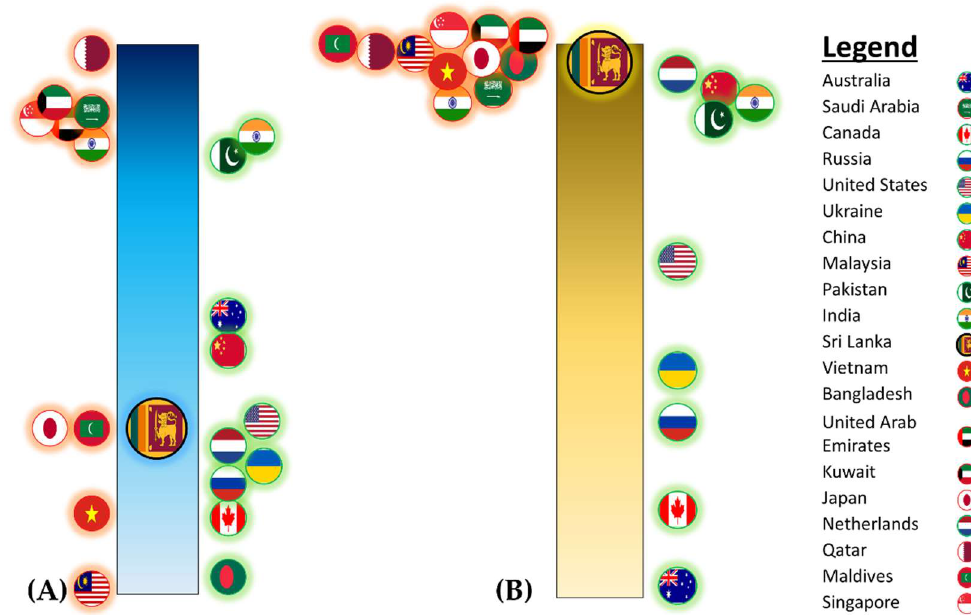
Figure 17. Water stress and arable land stress values normalized for the top trade partners: ( A ) shows the normalized ranking of water stress ranging from zero to one (bottom to top), whereas ( B ) shows the arable land stress for the trade partners. The green shading shows the countries supplying crops to Sri Lanka, while the red shows the countries receiving the